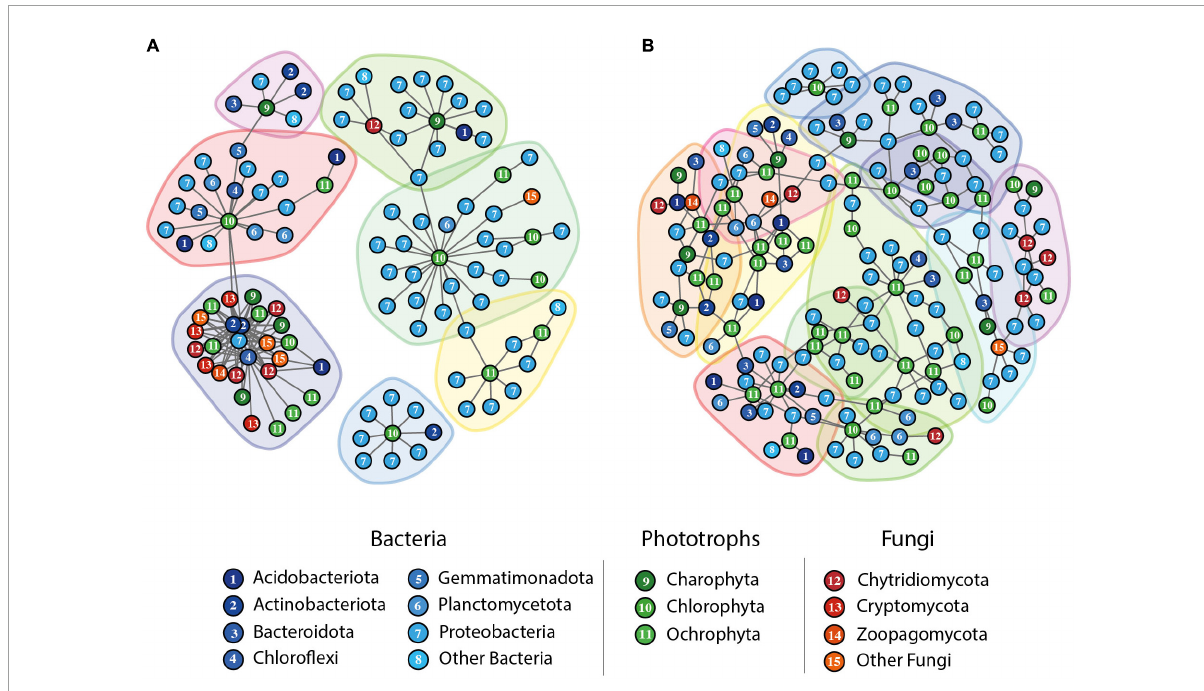
FIGURE4 Co-occurrence Networks between prokaryotic and eukaryotic organisms. Only the top 10% positive interactions between prokaryotic and eukaryotic (phototrophs + fungi) organisms are displayed. (A) GFS network with n = 92 GFS sites and (B) TRIB network with n = 106 tributary samples. Clusters were computed using the fast-greedy algorithm and all clusters with less than 5 nodes were removed. Colors differentiate bacteria (blue), phototrophs (green), and fungi (red) and number provides information on the nodes’ specific